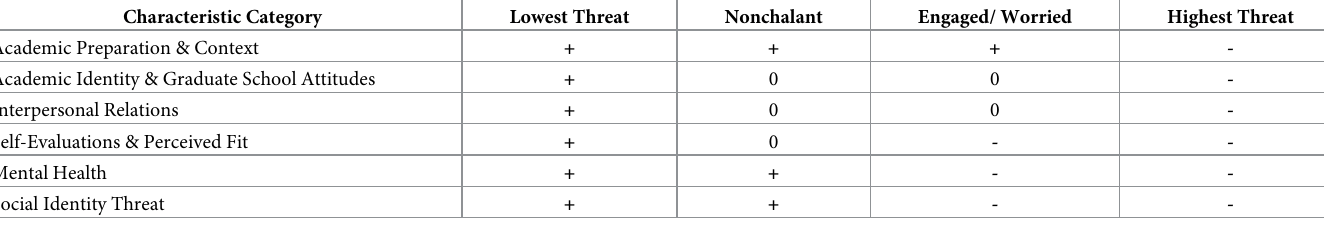
Table 6. A summary of how class membership is associated with descriptive characteristics. Characteristic